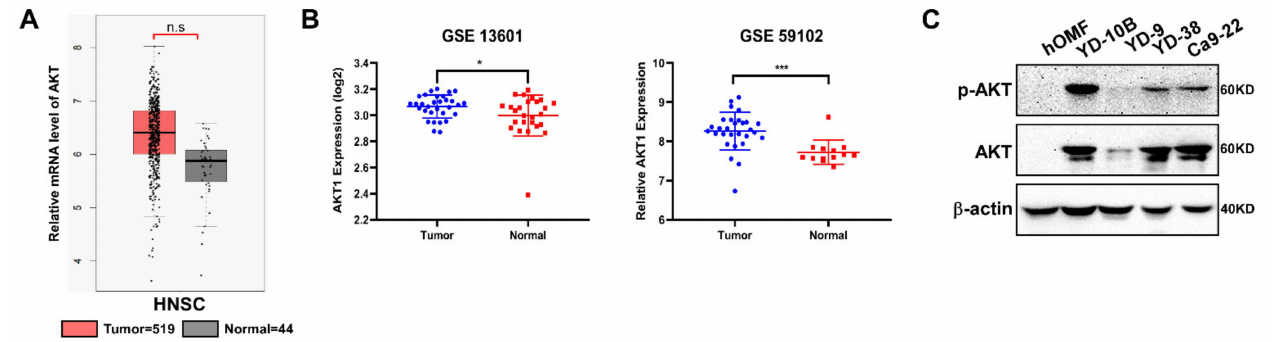
Figure 1. AKT expressed in OSCC. ( A ) The average expression level of AKT in patients with HNSC in TCGA and GTEx oral cancer dataset; ( B ) AKT expression in OSCC from GSE13601 and GSE59102. * p < 0.05, *** p < 0.001 indicate a significant difference compared with control; ( C ) The expression of AKT in oral cancer cell